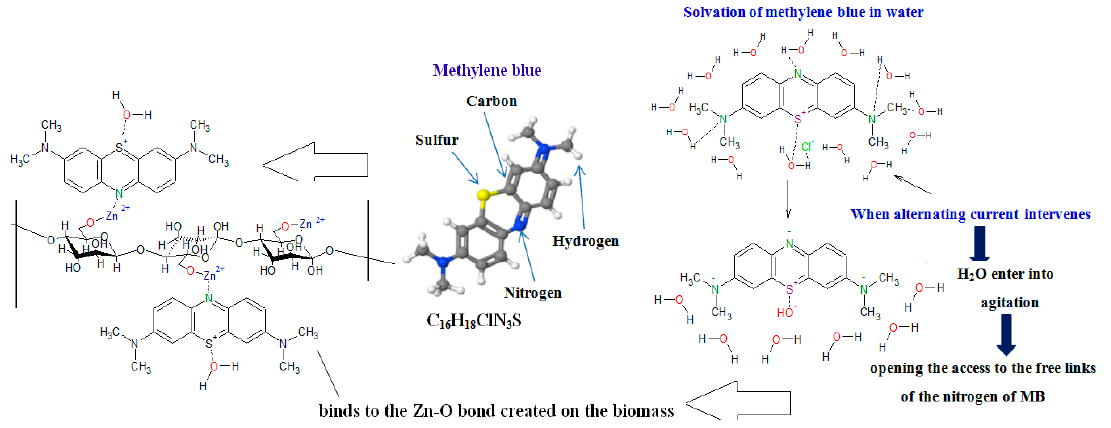
Figure 7. Possible pathway for the fixation of Zn 2 + onto the L.C surface.